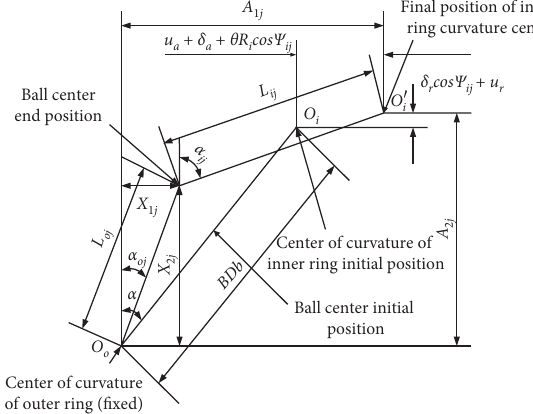
Figure 4: Internal displacement change of ball bearings considering EHL.